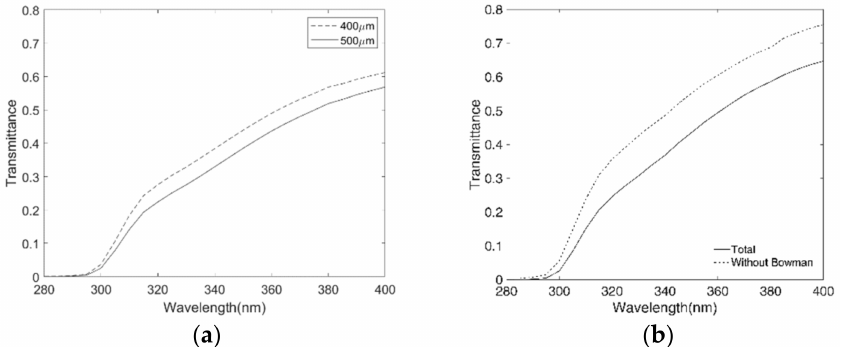
Figure 3. Changes in transmittance in the ultraviolet A+B region for: ( a ) total cornea with two stroma thicknesses (400 µ m and 500 µ m) and ( b ) total cornea with and without Bowman’s layer. Data of average thickness of each layer in a normal cornea have been used for this simulation: 50 µ m for the epithelium, 10 µ m for Bowman’s layer, 500 µ m for stroma, 9 µ m for Descemet’s layer, 5 µ m for the endothelium